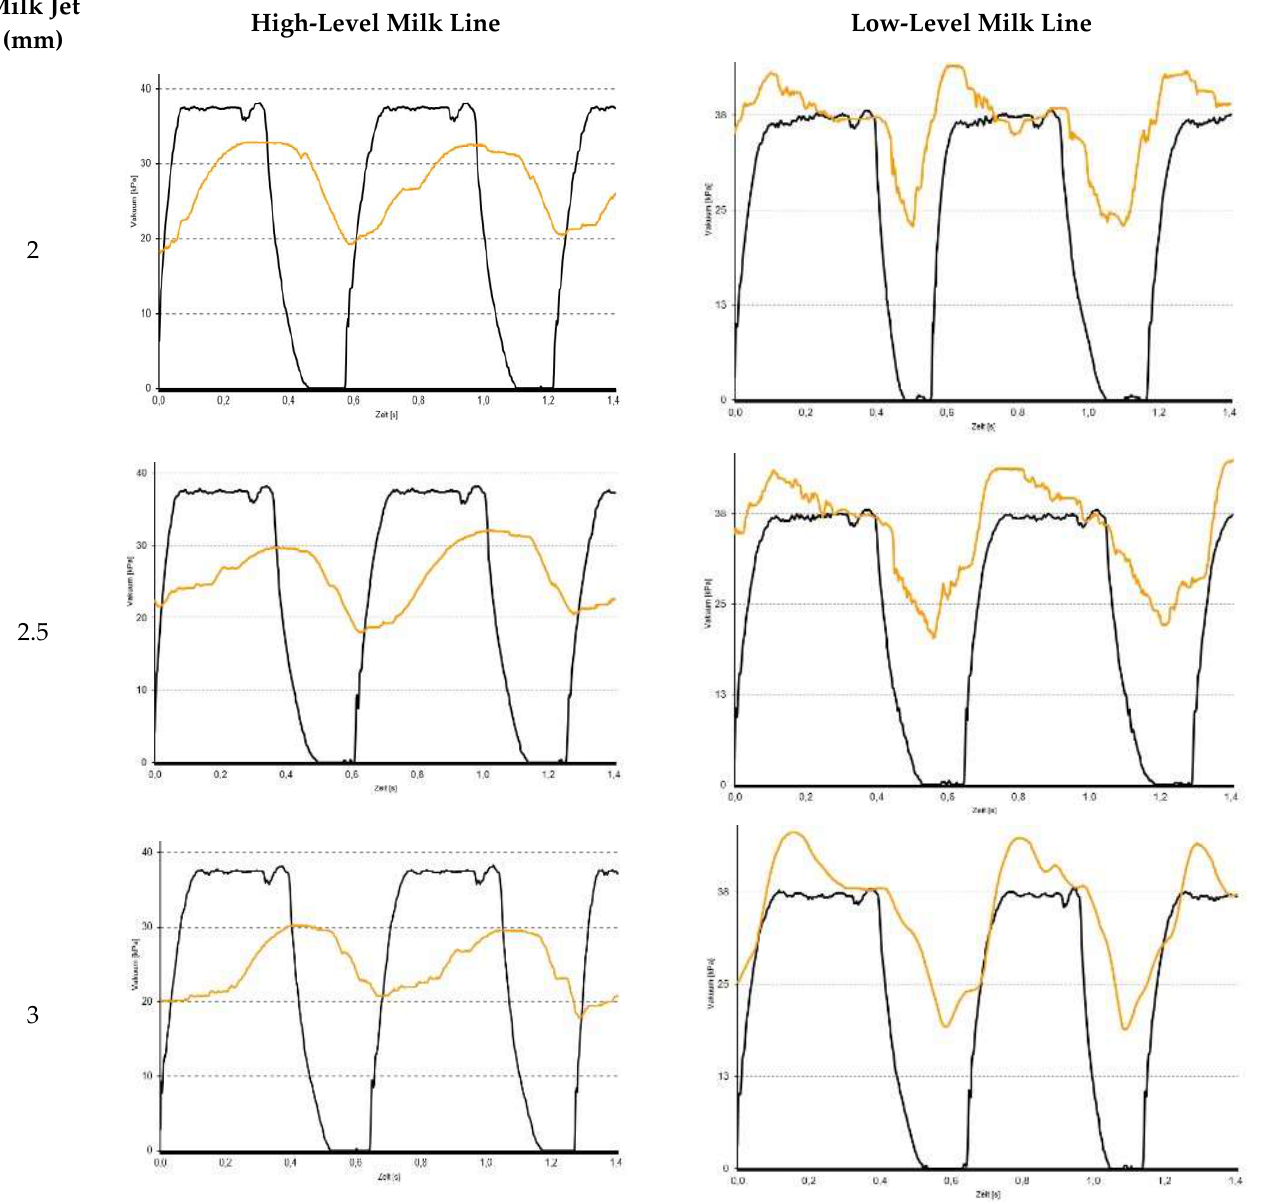
Figure 6. Cyclical vacuum fluctuations in the pulsation and inner chambers of the teat cup during the 1st WF in the goat milking machine, with the following settings: 36 vacuum level (kPa), 90 pul- sation rate (cycles/min) and 60:40 pulsation ratio.